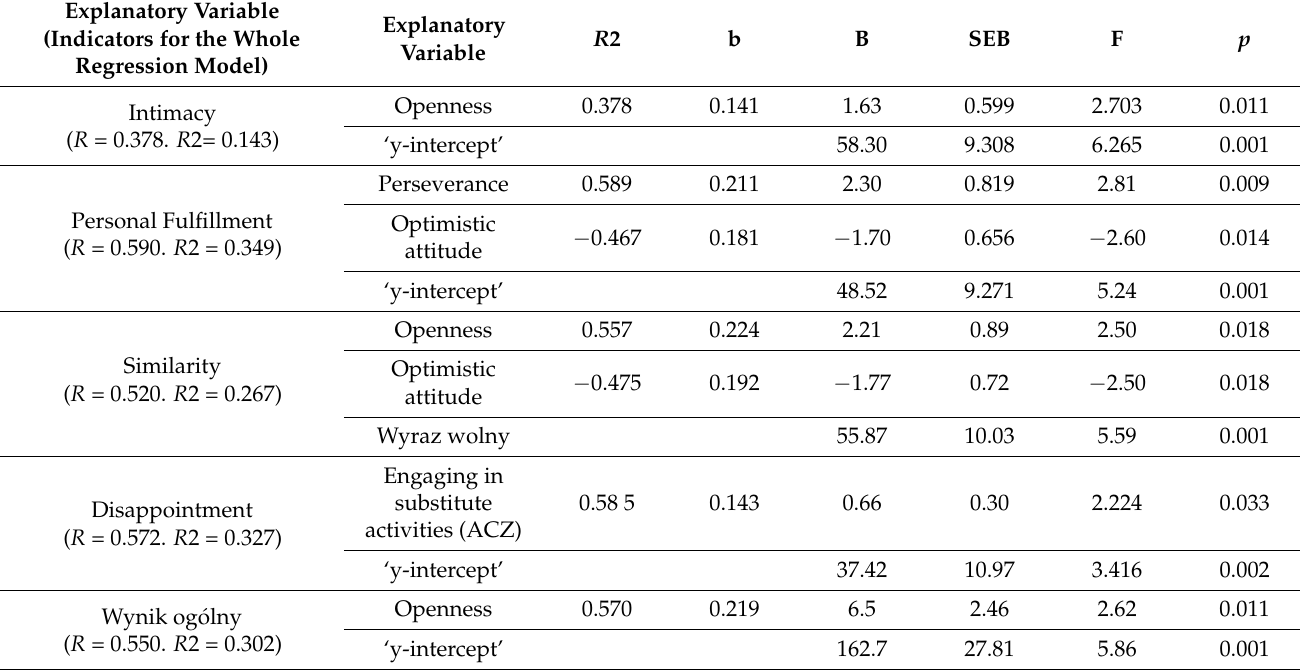
Table 3. Predictors (resilience, stress coping styles) of marital satisfaction among the studied